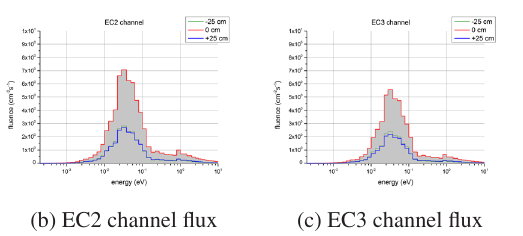
Figure 4: Neutron flux and spectra calculations for exper- imental channels